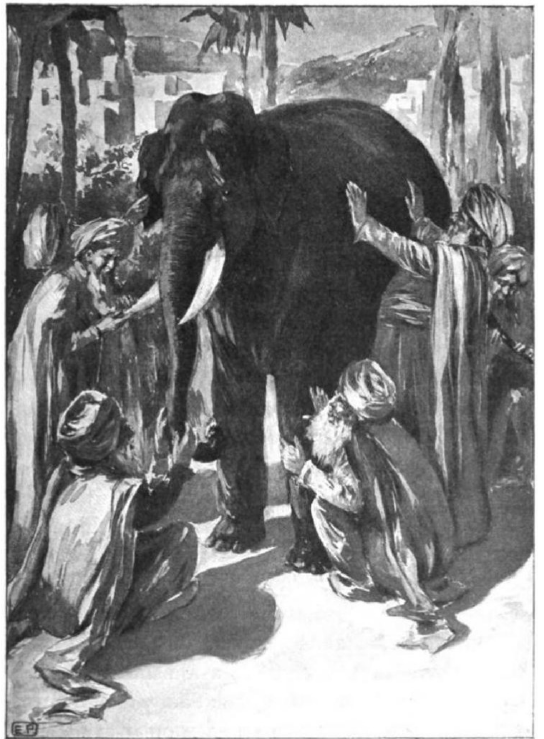
Figure 1. By illustrator unknown from The Heath readers by grades , D.C. Heath and Company (Boston), p. 69, Public Domain [1].